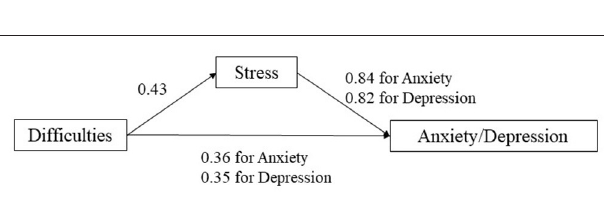
FIGURE 1 | Effects of need satisfaction on anxiety and depression with stress as the mediator.